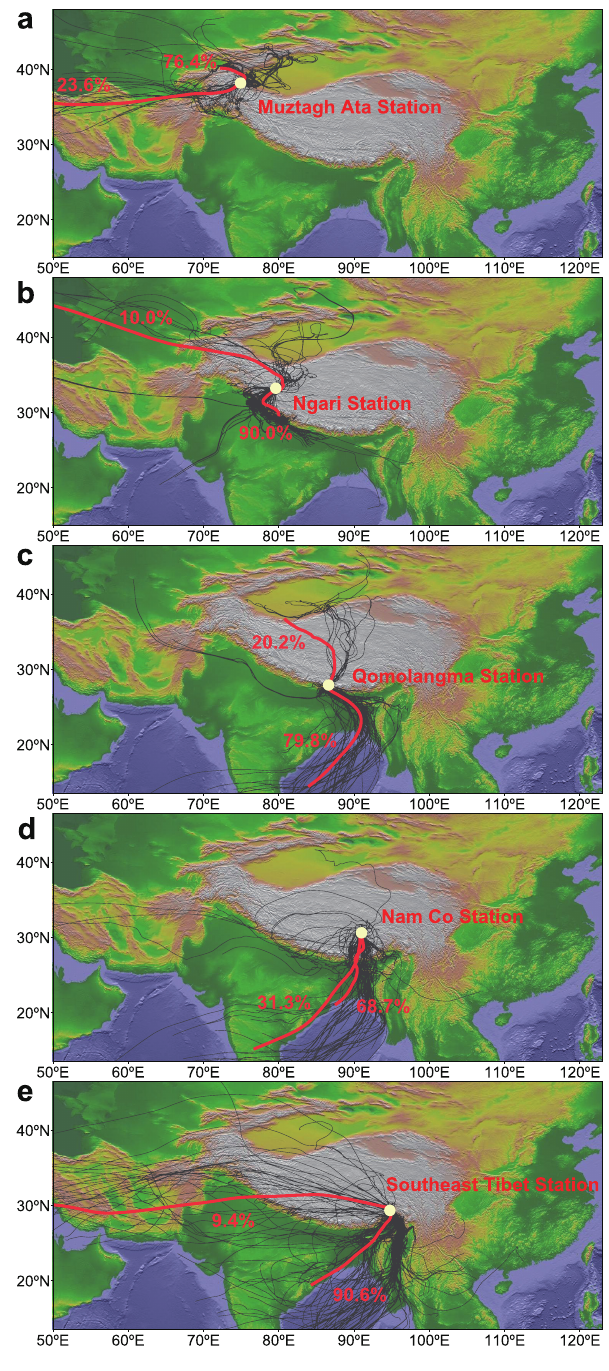
Figure 5. Seven-day backward trajectories at five remote sites in the TP. Black lines show the backward trajectories calculated at 6h intervals (00:00, 06:00, 12:00, 18:00UTC) on sampling days, with an arrival height of 500m above the ground. Red lines show the clustering